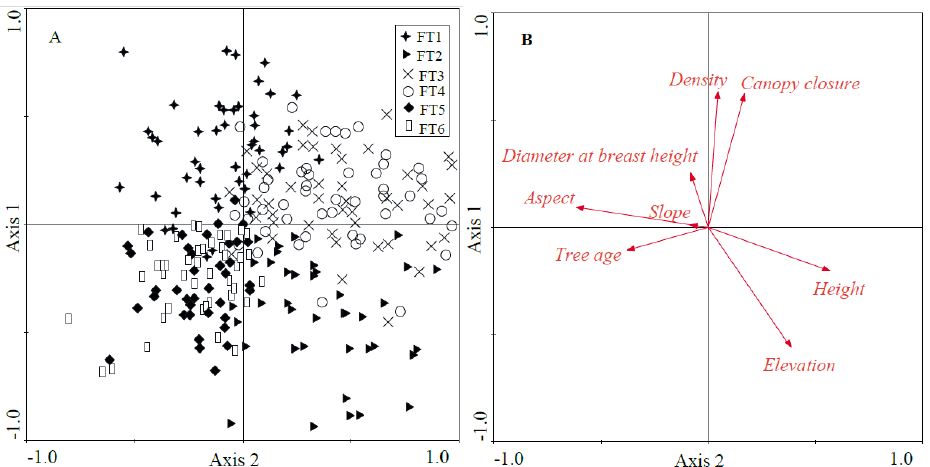
Figure 4. Representation of (A) plots of the six forest types and (B) environmental factor variables on the first two axes of the canonical component analysis. n = 253